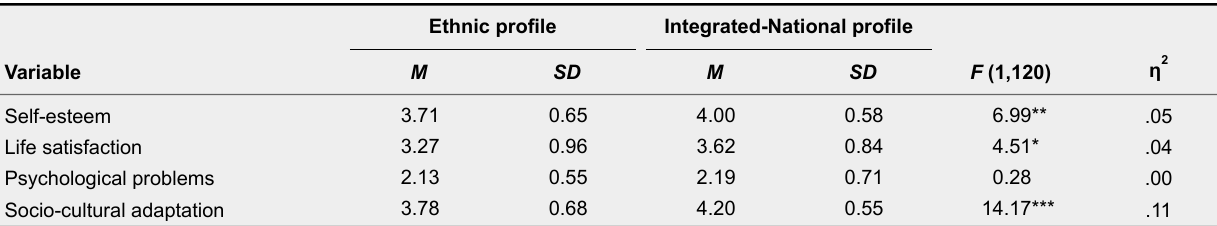
Means and Standard Deviations of Tunisian Adolescents’ Adaptation Variables